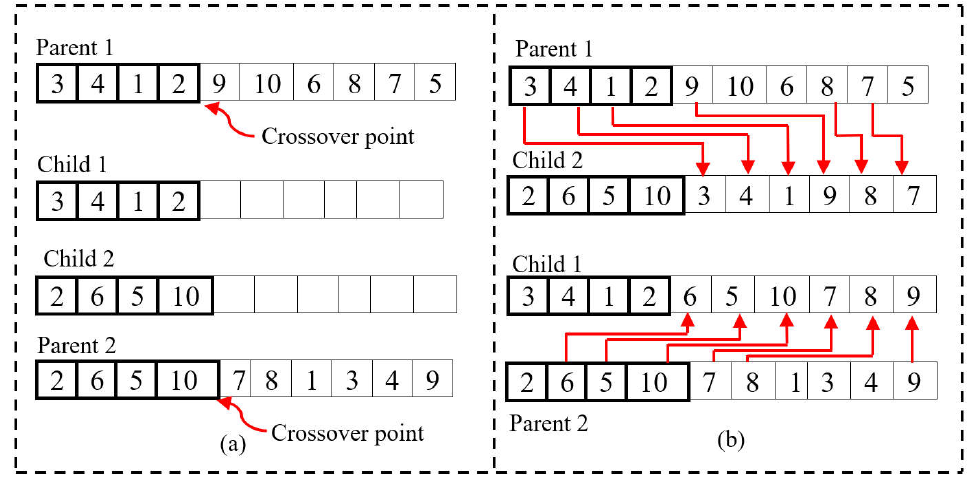
Figure 8. Illustration of single point crossover: ( a ) Step-1, and ( b ) Step 2.